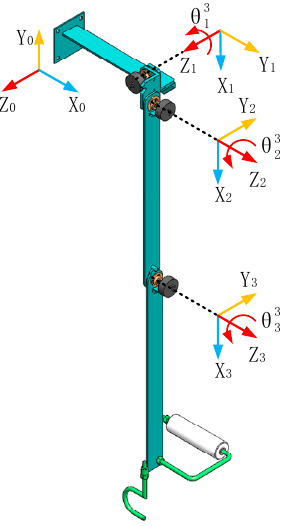
Figure 3. Kinematic configuration and coordinates of the 3-DOF upper-limb exoskeleton. As described in Figure 2, the 5-DOF upper-limb exoskeleton is an anthropomorphic structure. The length of the upper-arm and the forearm can refer to the human body, but the 3-DOF upper-limb exoskeleton is a non-anthropomorphic structure. The length of the upper-arm O 1 A 1 and forearm A 1 B 1 is determined by the workspace of the 5-DOF upper-limb exoskeleton and the angle α between the forearm of the exoskeleton and the sagittal plane, shown in Figure 4a, so that the 3-DOF upper-limb exoskeleton has the same workspace as the 5-DOF upper-limb exoskeleton.